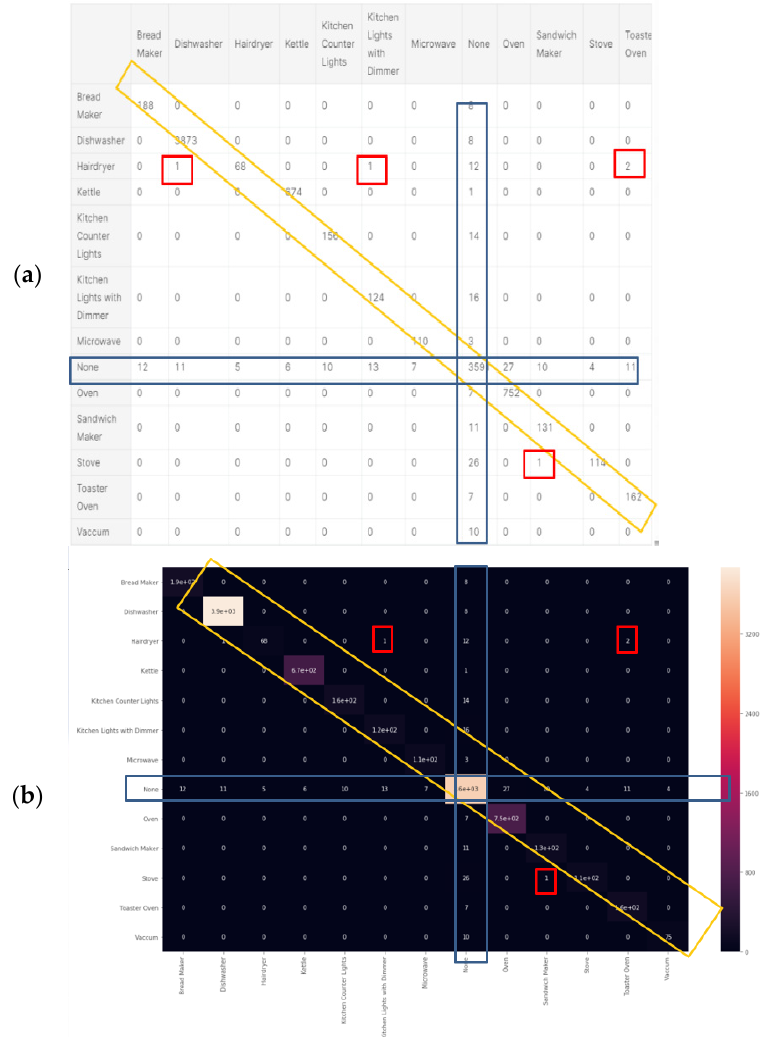
Figure 13. Ridge classifier ( a ) confusion matrix and ( b ) correlation heatmap.